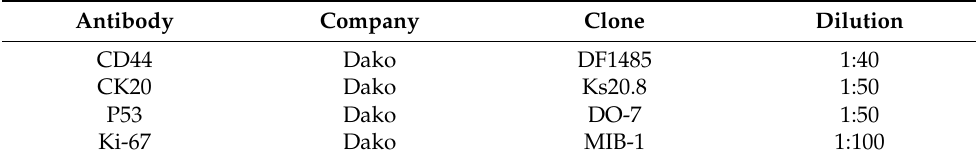
Table 2. Detailed information of the antibodies used in this